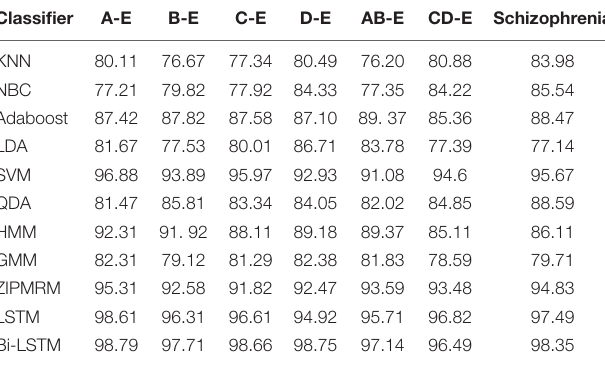
TABLE 2 | Performance analysis of Fusion Hybrid Model (FHM) and Hybrid Differential Particle Artificial Bee (HDPAB) for different datasets in terms of